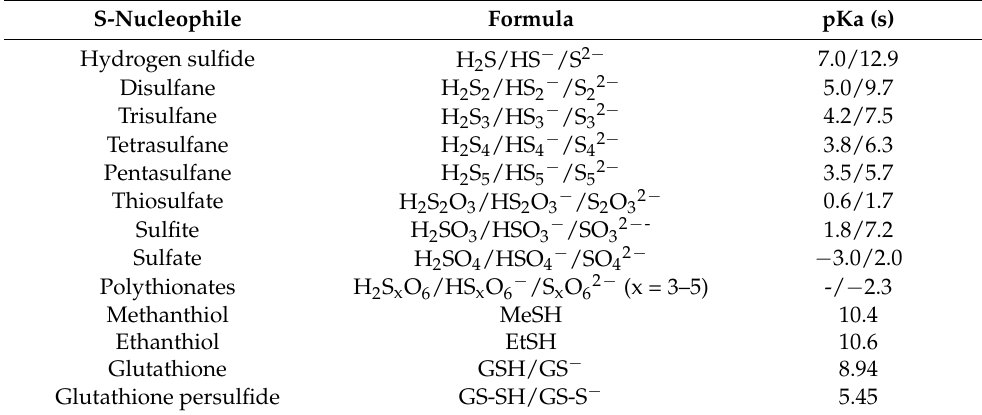
Table 2. pKa of selected sulfur species in wine (based on